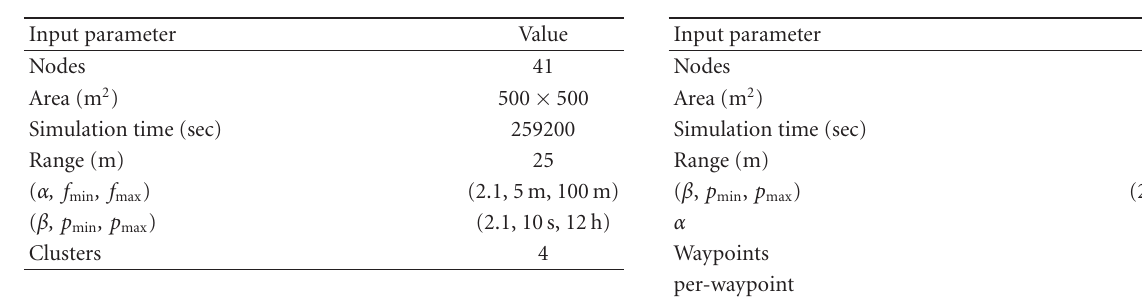
Table 2: Input parameter values of TLW for the Infocom’05 sce- nario listed in Table 1. See [3] for details on the parameters.